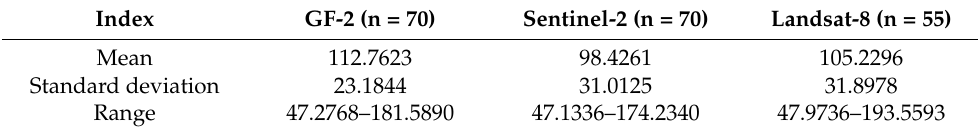
Table 1. The AGB statistical information of the field measurements at pixel scale (Unit: t/ha).